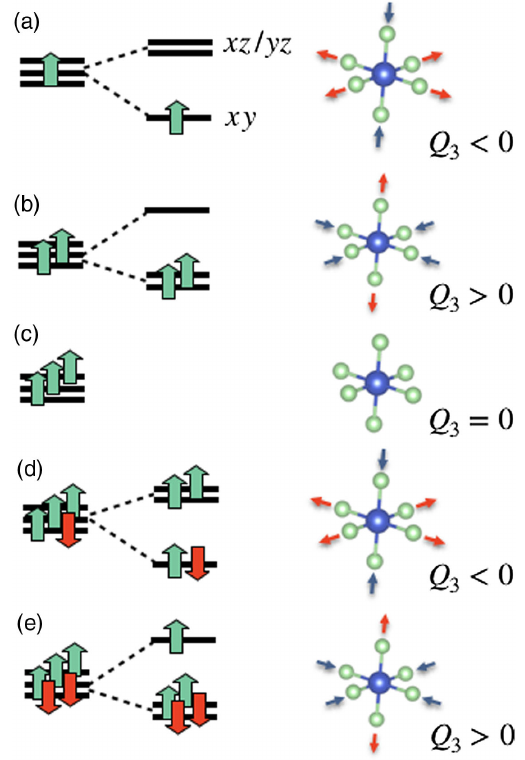
FIG. 1. Diagrams of crystal-field splitting due to the Jahn-Teller effect without spin-orbit coupling for different number of electrons: (a) d 1 , (b) d 2 , (c) d 3 , (d) d 4 , and (e) d 5